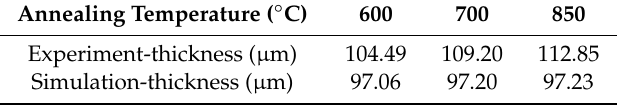
Figure 12. Equivalent strain distribution of finite element model. Table 3. The thickness of round corner after springback for Cu / Ni with a bending angle of 60 ◦ . Table 3. The thickness of round corner after springback for Cu/Ni with a bending angle of 60°. Annealing Temperature (°C)